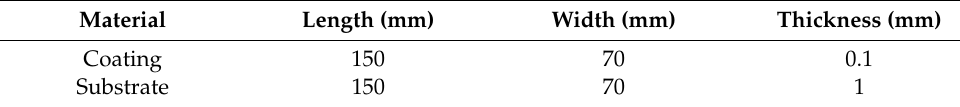
Table 6. Dimensions of the coating and substrate.